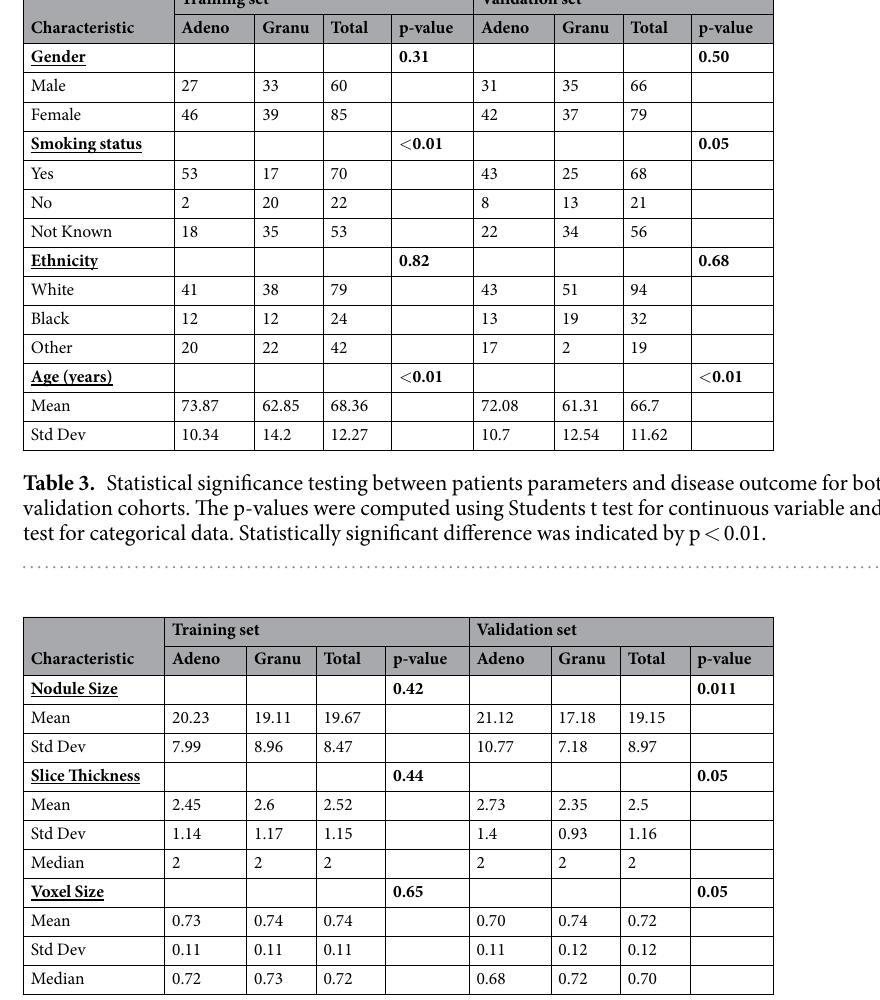
Table 4. Statistical significance testing between CT parameters and disease outcome for both training and validation cohorts. The p-values were computed using two tailed and unpaired Students t test. Statistically significant difference was indicated by p <